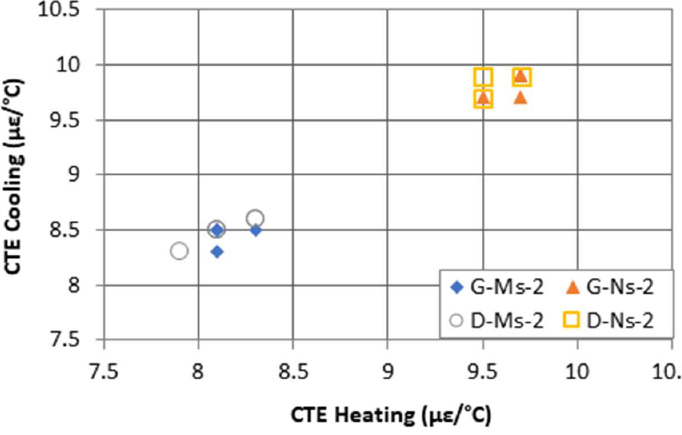
Figure 4. Effect of low volume of coarse aggregate and high volume of fine aggregate on concrete CTE.